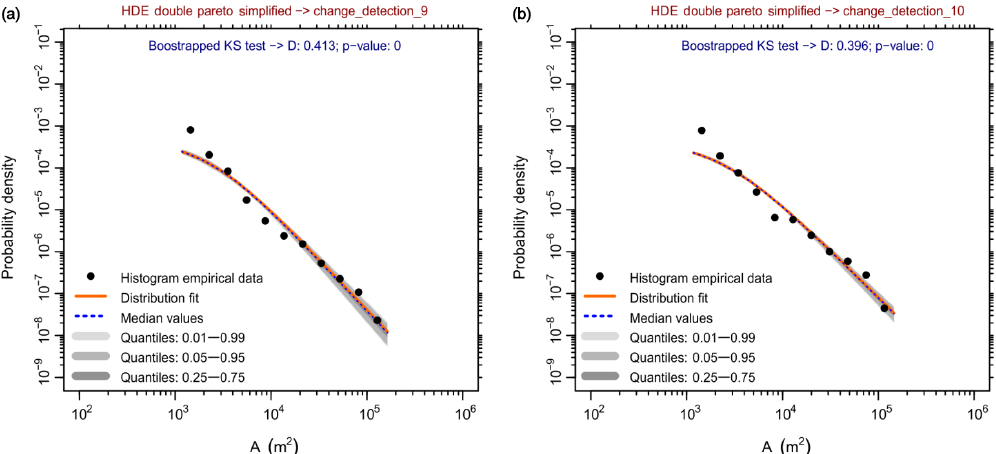
Figure 9. Frequency–area distribution of segments resulting in the change detections 9 (a) and 10 (b) and fitting with a Double Pareto simplified